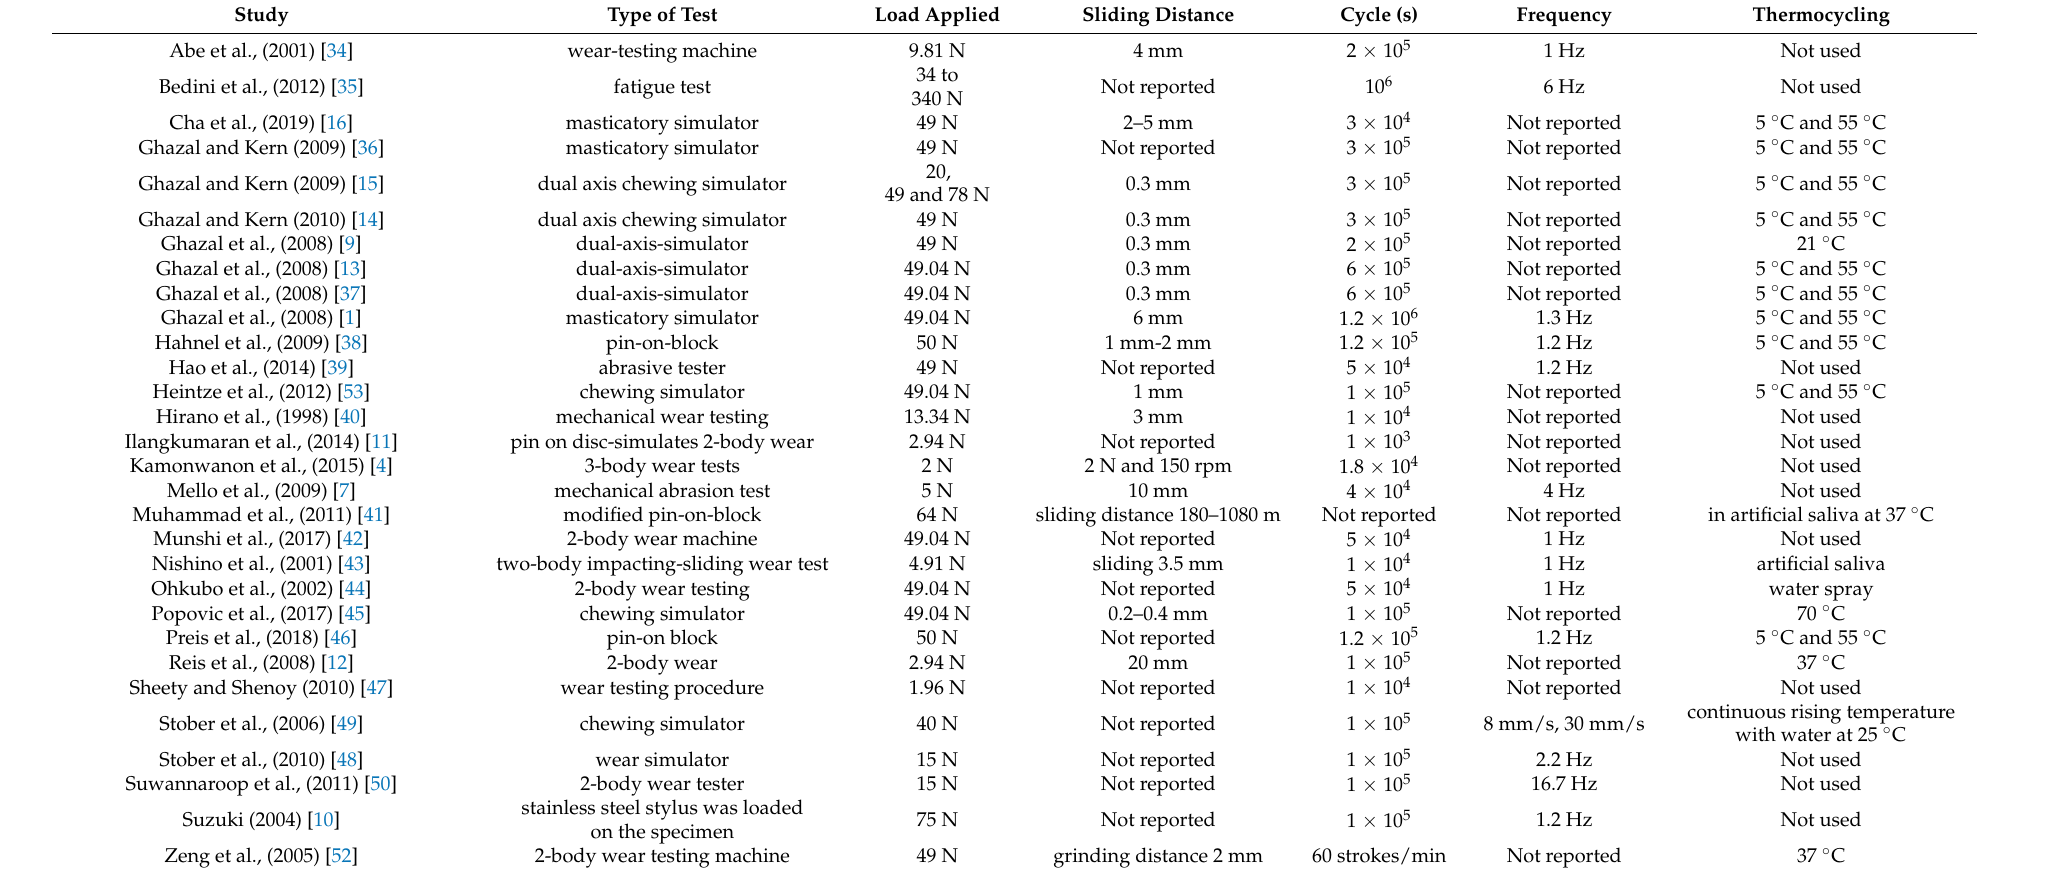
Table 2. Testing parameter of in vitro studies (Note: All loads converted to newtons 1 kg = 9.81 N; 1 pound = 4.448